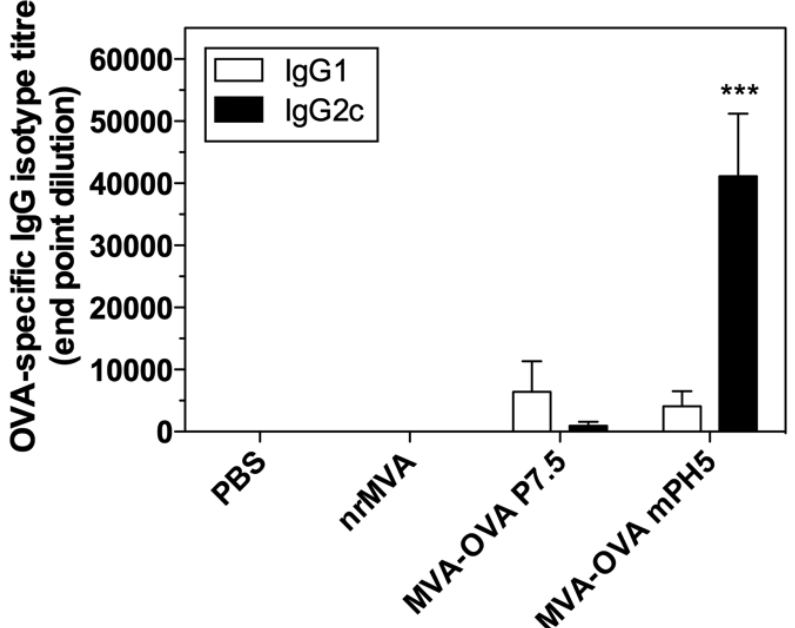
Figure 6. OVA-specific IgG1/IgG2c in sera of mice vaccinated with MVA-OVA P7.5 and MVA-OVA mPH5. OVA-specific IgG1 and IgG2c isotypes were determined by ELISA. Each bar represents the group mean end-point titre, the SEM is indicated by vertical lines. The results were statistically significant at p < 0.001 (***) compared to all